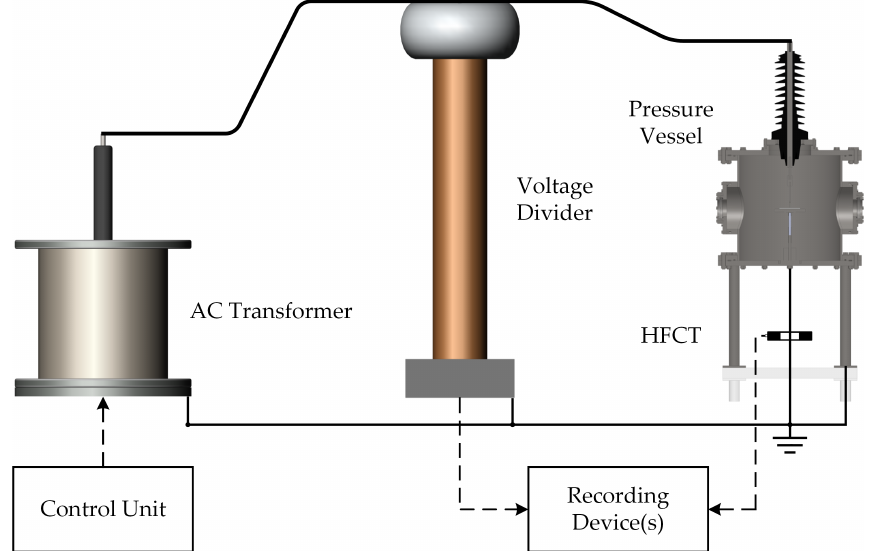
Figure 4. Experimental set-up for AC voltage application to the needle-plane configuration and insulator